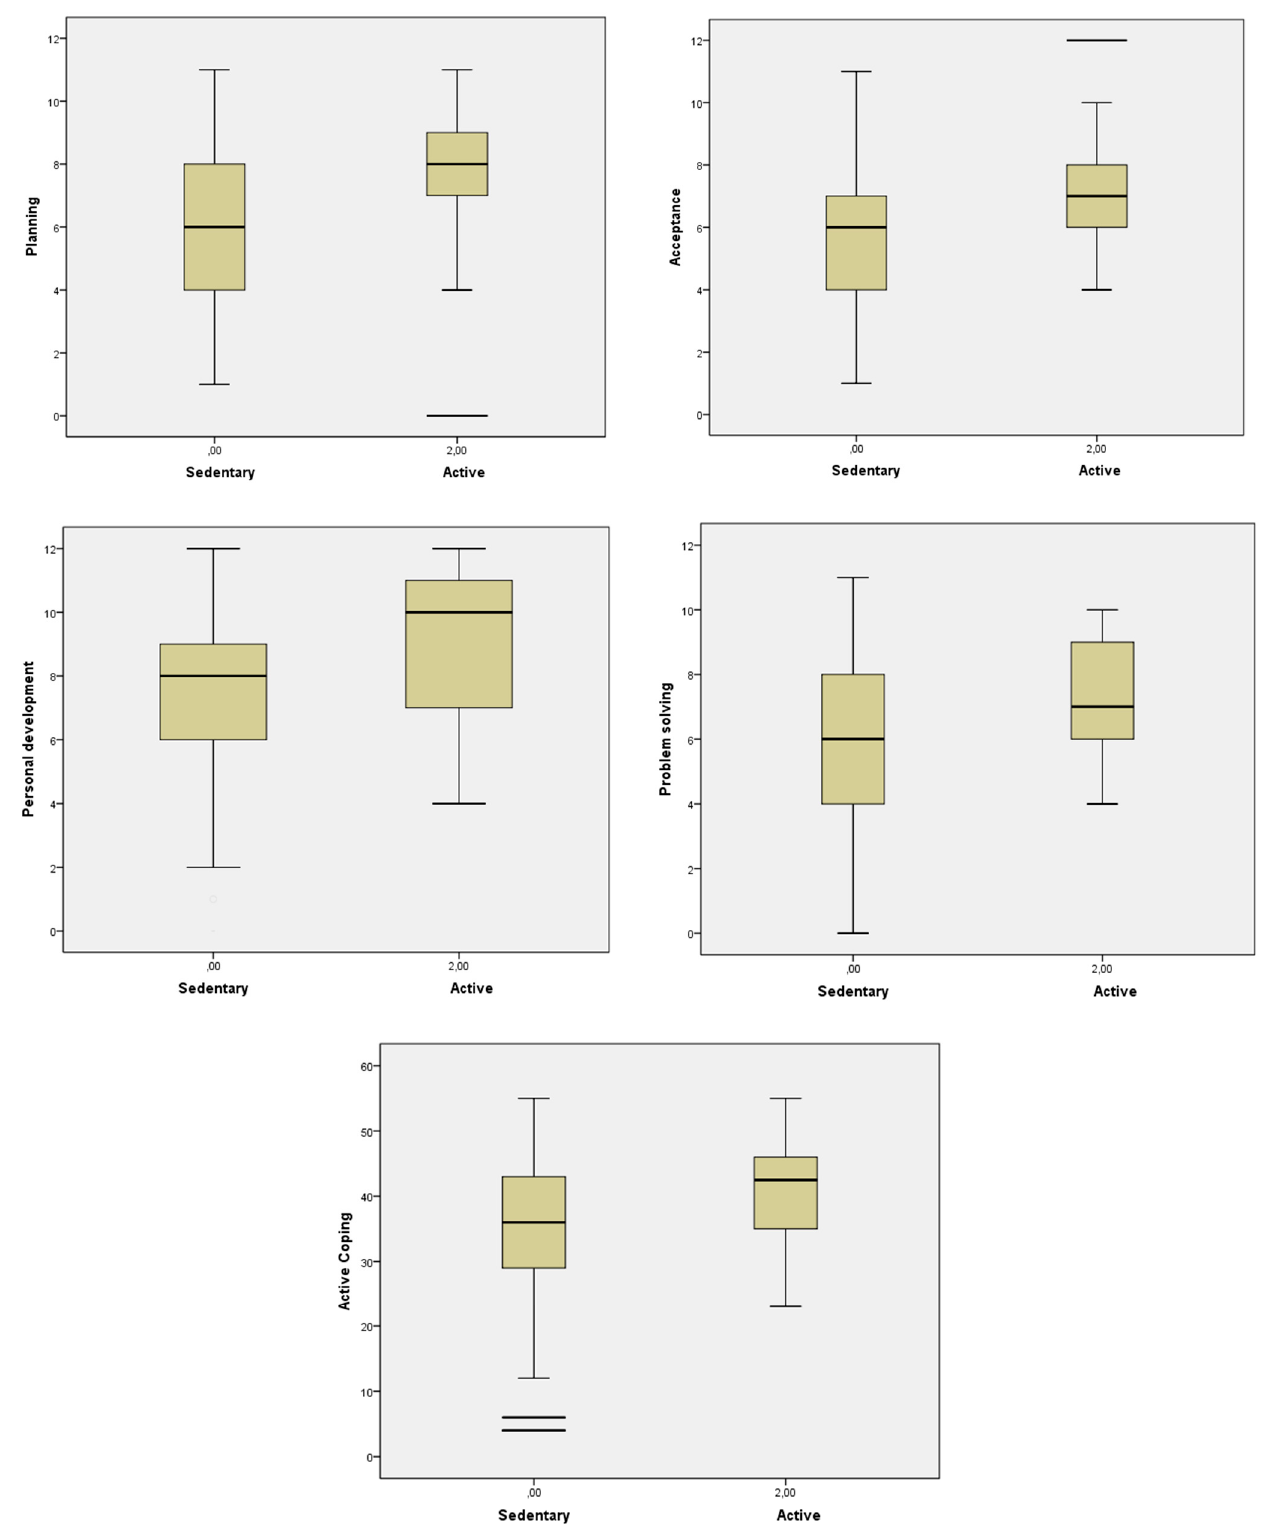
Figure 2. Comparisons of coping strategies between the different levels of physical exercise practice: SA (sedentary) vs. AA (active).